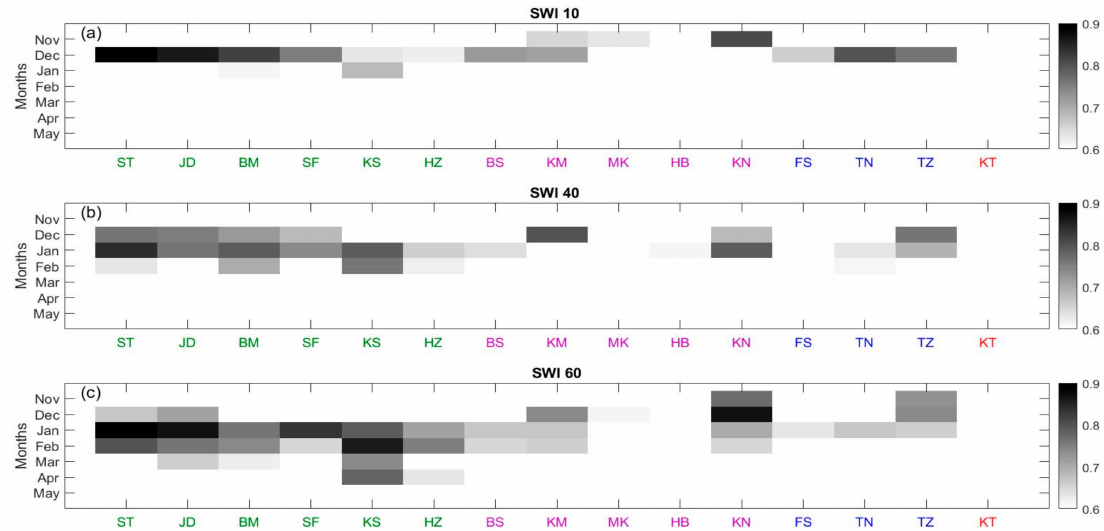
Figure 5. Correlation between the SWI 10 ( a ), SWI 40 ( b ), SWI 60 ( c ) and cereal yield at the province scale: Settat, JD: El Jadida, BM: Beni Mellal, SF: Safi, KS: Kelaa des Sraghna, HZ: Haouz, BS: Ben Slimane, KM: Khemisset, MK: Meknes, HB: El Hajeb, KN: Khenifra, FS: Fes, TN: Taounat, TZ: Taza, KT: Kenitra. All the correlations are significant at the 99%